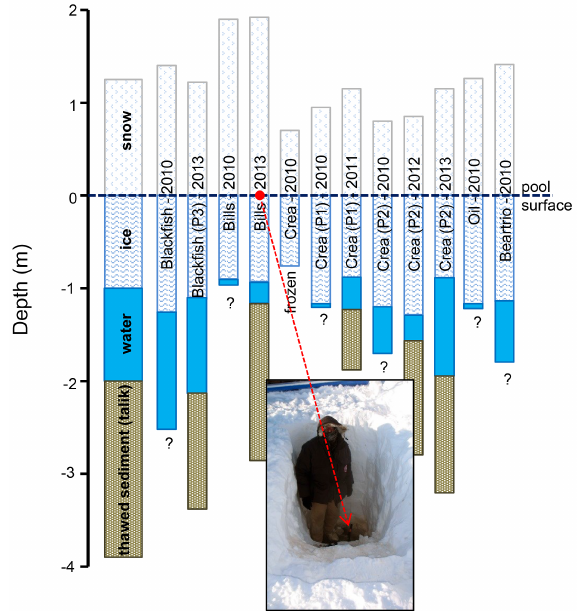
Figure 10. Diagram of generalized sediment core stratigraphy from a large pool in Crea Creek (indicated in Fig. 9) collected in both 2012 and 2013 showing the location of macrofossil fragments col- lected for radiocarbon dating. The sharp transition from organic- rich gyttja to medium sand is interpreted to be the base of the pool at its time of formation.